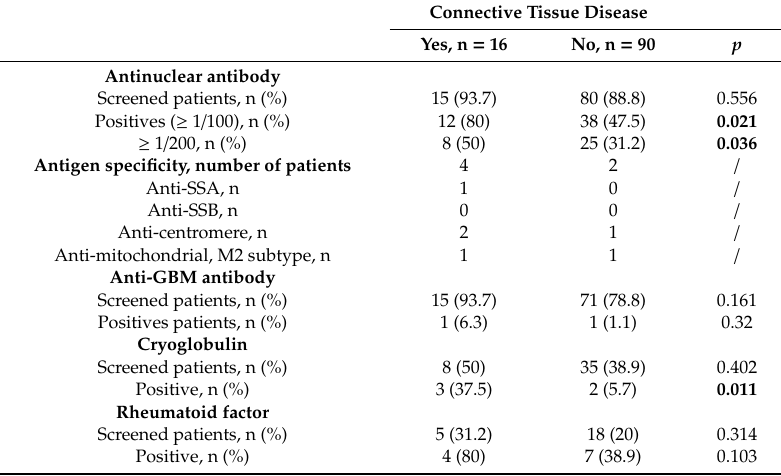
Table 3. Immunological presentation according to groups. Significant p values appear in bold.